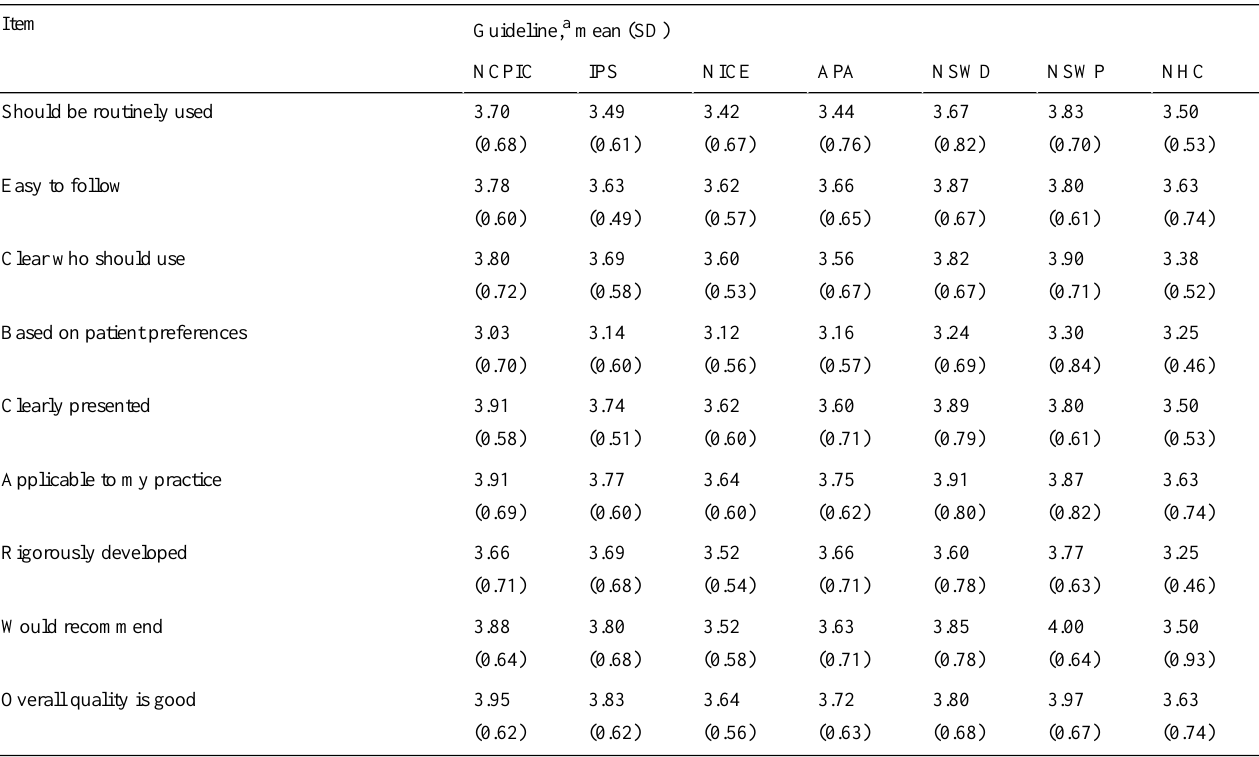
Table 5. Treatment providers’opinions regarding the clinical practice guidelines. Guideline, a mean (SD)Item